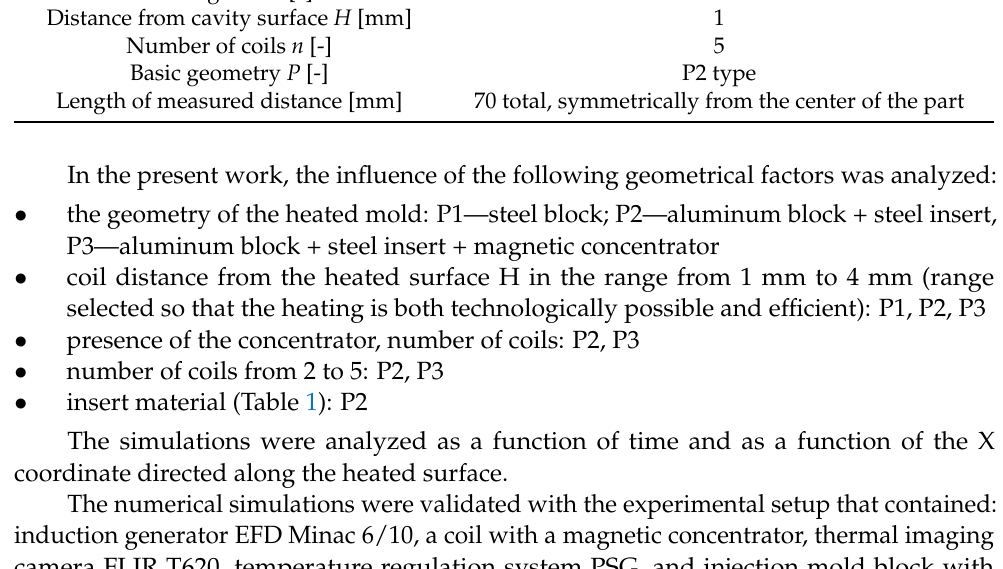
Table 2. Input data for simulation research.